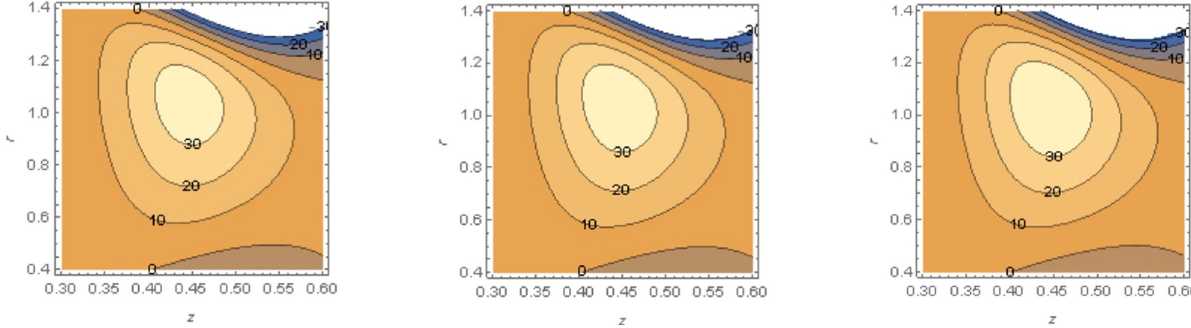
Figure 21: Various values of the wave frame streamlines of Q 5 = { 0.2, 1.0, 1.8 } at W